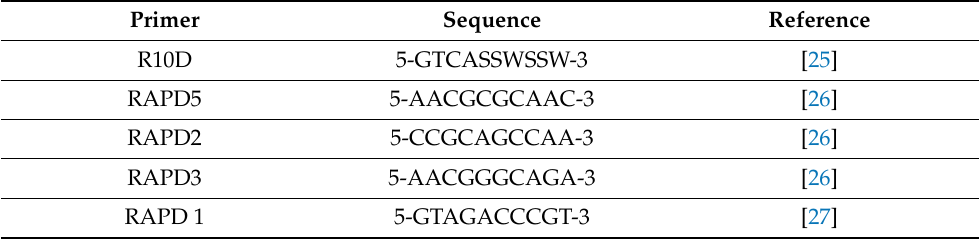
Table 1. Primers used in RAPD-PCR; S and W represent G/C and A/T, respectively.